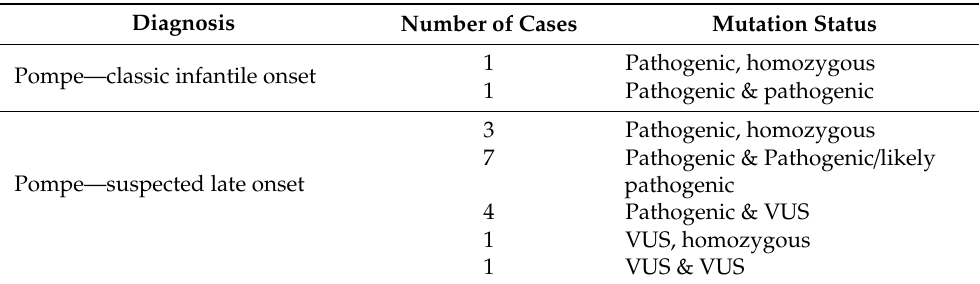
Table 5. Mutation status of diagnosed cases identified by California newborn